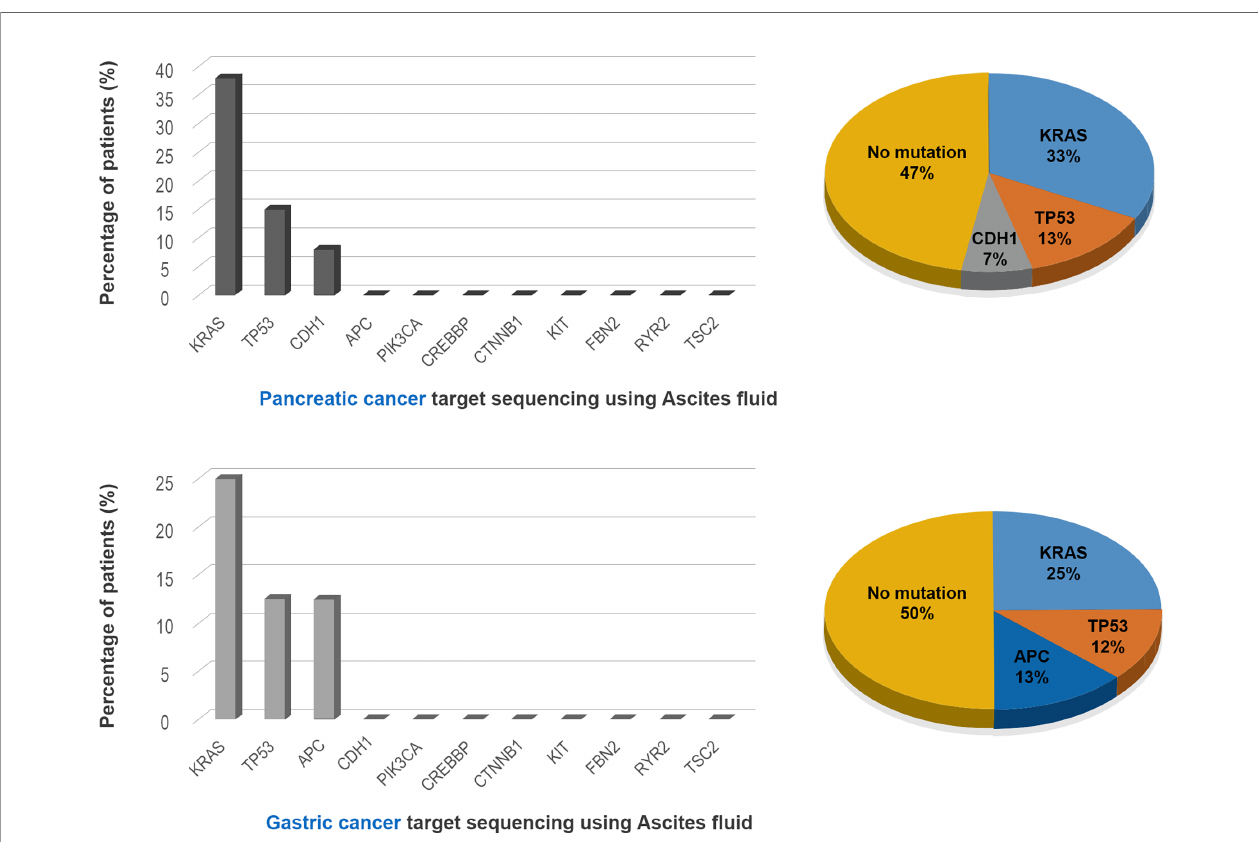
FIGURE 4 | Detection of mutated genes in the ascitic fl uid in the pancreatic and gastric cancer